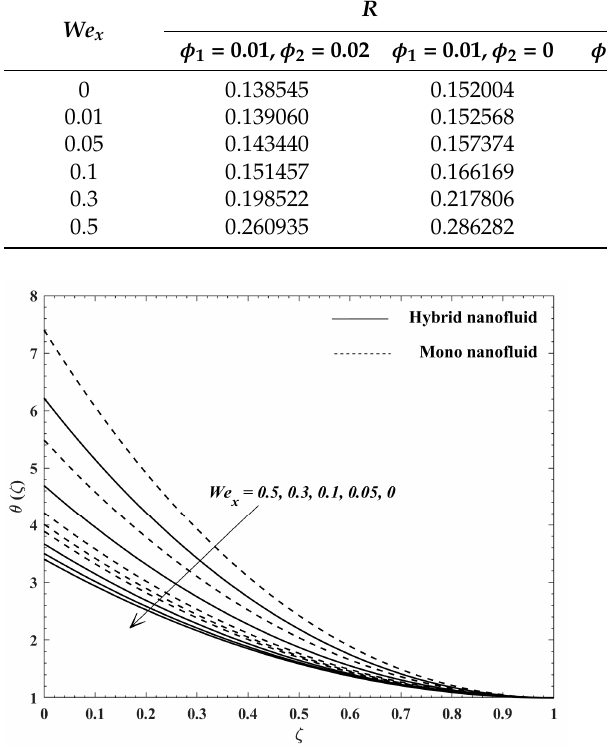
Figure 2. Under the given conditions of m = 1.4, ε = 0.8,Pr = 7, S = − 1, and M = 1.2, the temperature profiles exhibit changes as We x varies. The variations in We x can result in significant changes in the temperature distribution, and the temperature profiles can provide valuable insights into the behavior of the system. Table 5. As the local Weissenberg number We x undergoes variation, numerical approximations are made for the local Nusselt number θ (cid:48) ( 0 ) based on specific parameters, including m = 1.4, ε = 0.8,Pr = 7, S = − 1, and M =